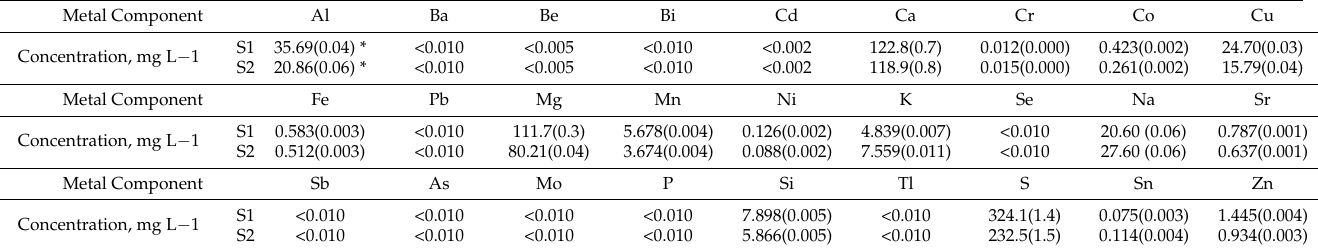
Table 5. Chemical metal composition of surface water samples determining by the ICP-OES method, mg L − 1 . Metal